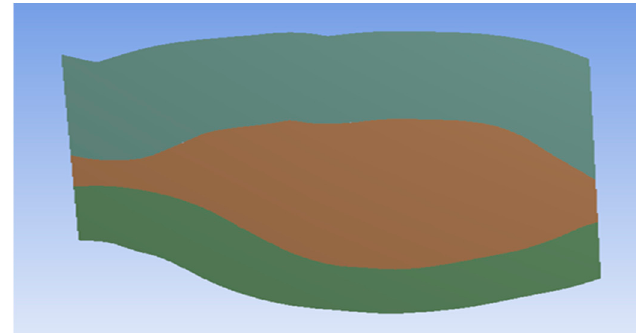
Figure 4. AAA geometry after conversion from 3D to 2D.